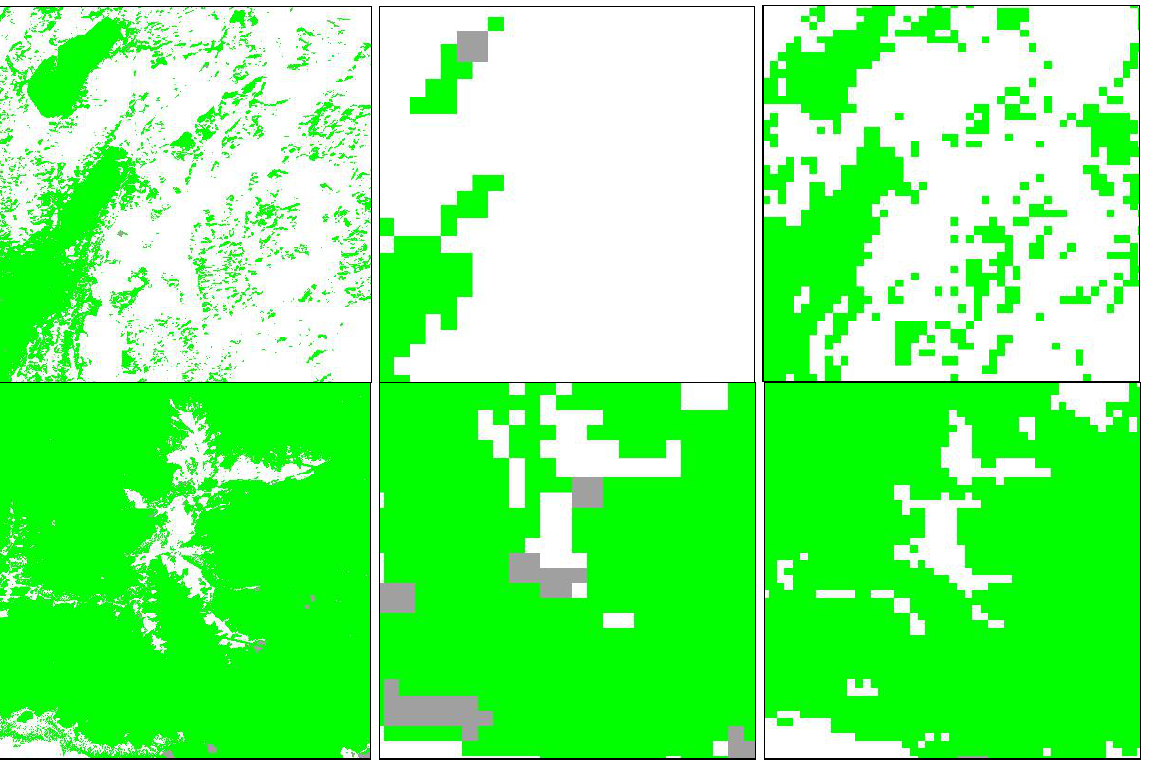
Figure 7. Comparison over patchy snow covered areas for the Landsat, NASA and EURAC snow cover maps (SCA) maps (respectively, from left to right). In the SCA maps, snow is indicated in white, snow-free areas in green and clouds in